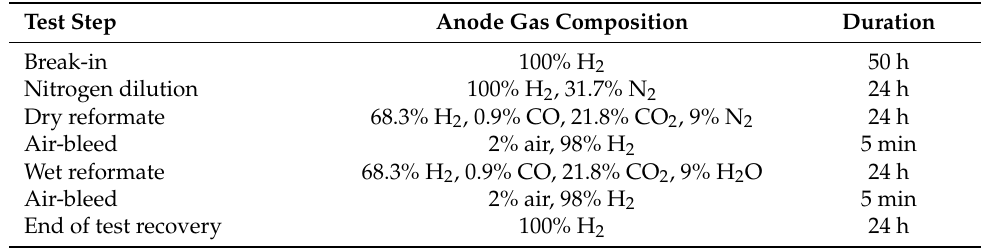
Table 1. The test procedures.